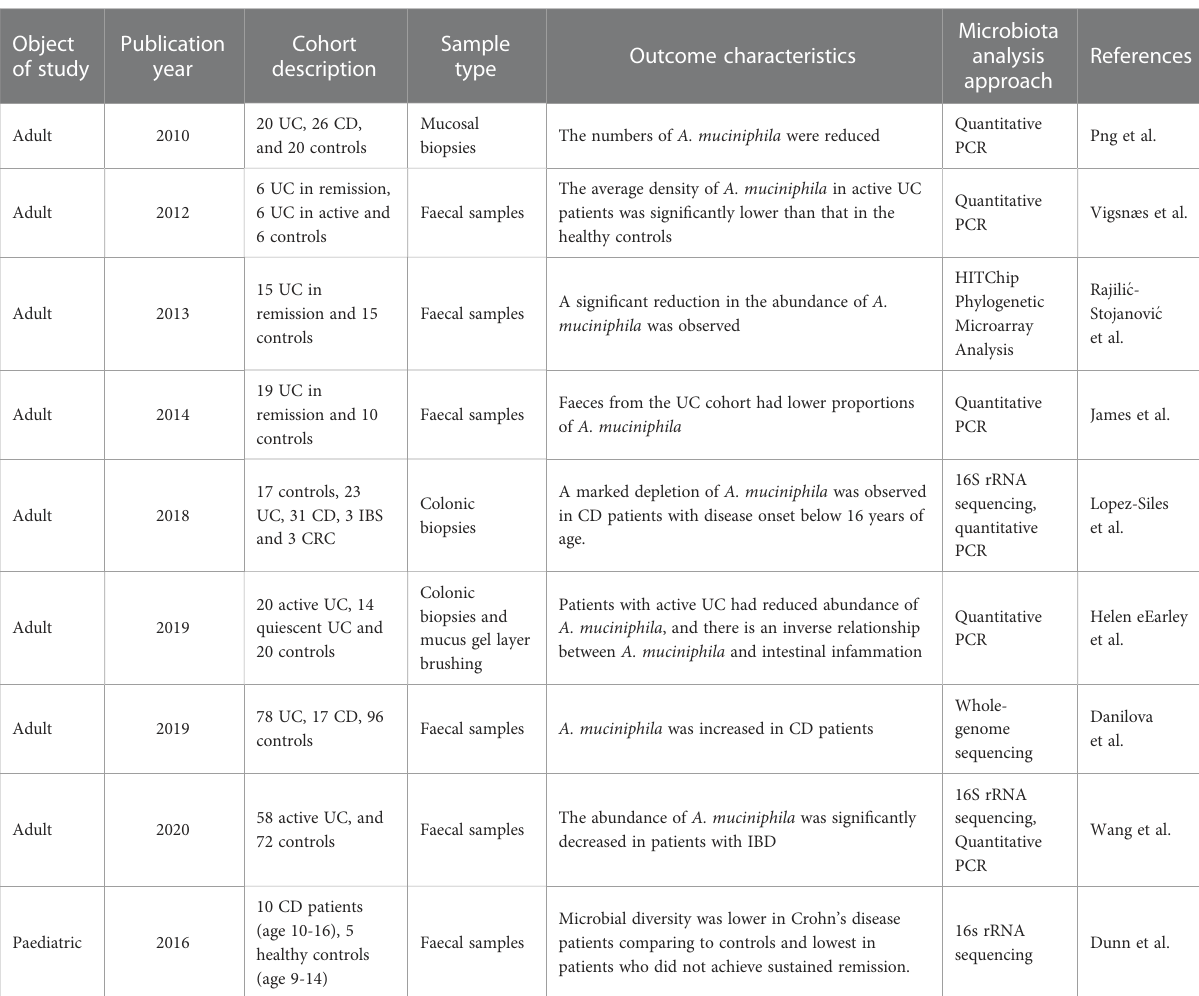
TABLE 1 Overview of clinical studies of A. muciniphila related to in fl ammatory bowel disease.